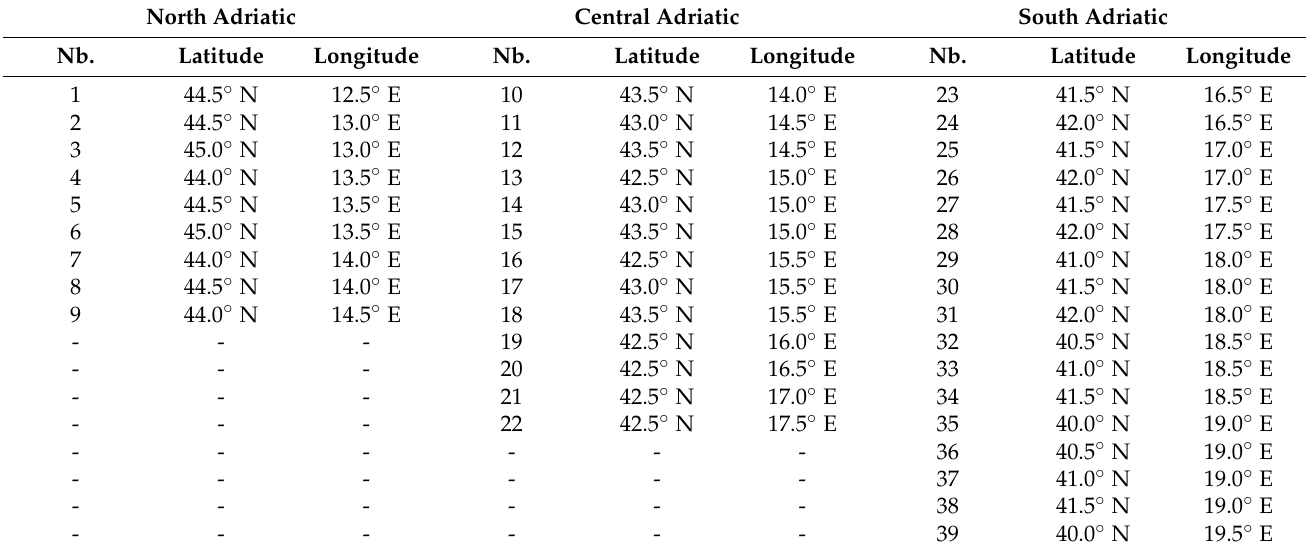
Table A1. Location numbering and coordinates with regional subdivision.